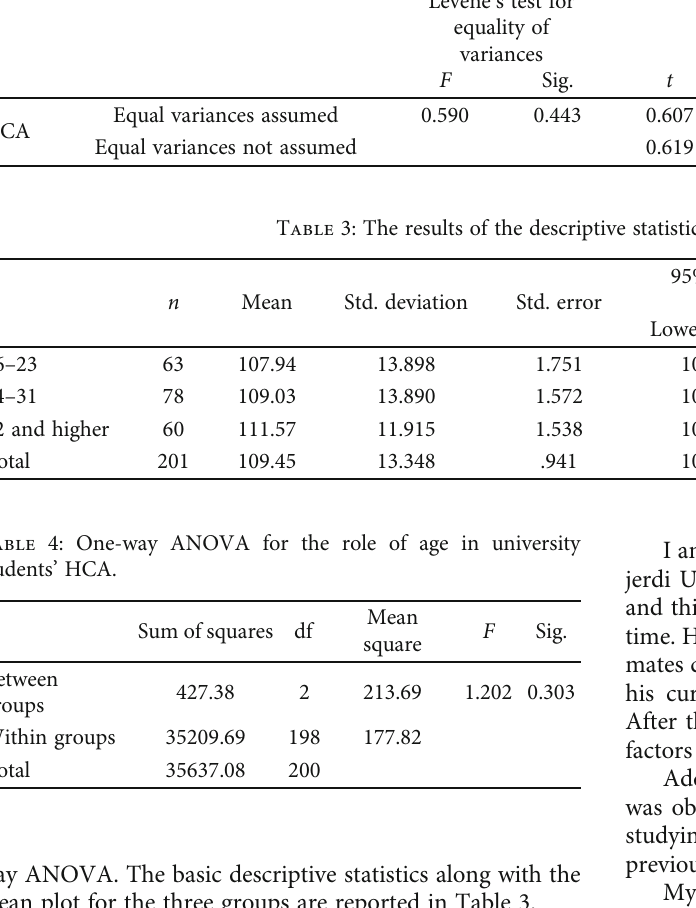
Table 2: Results of the independent samples test of male and female university students concerning HCA.